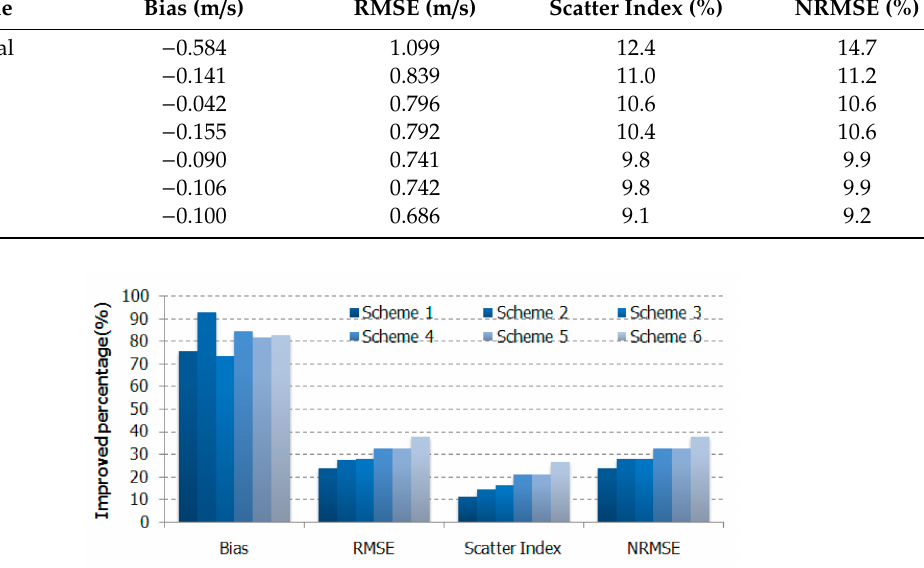
Figure 9. The percentage of the reduction of error by each wind speed calibration DNN